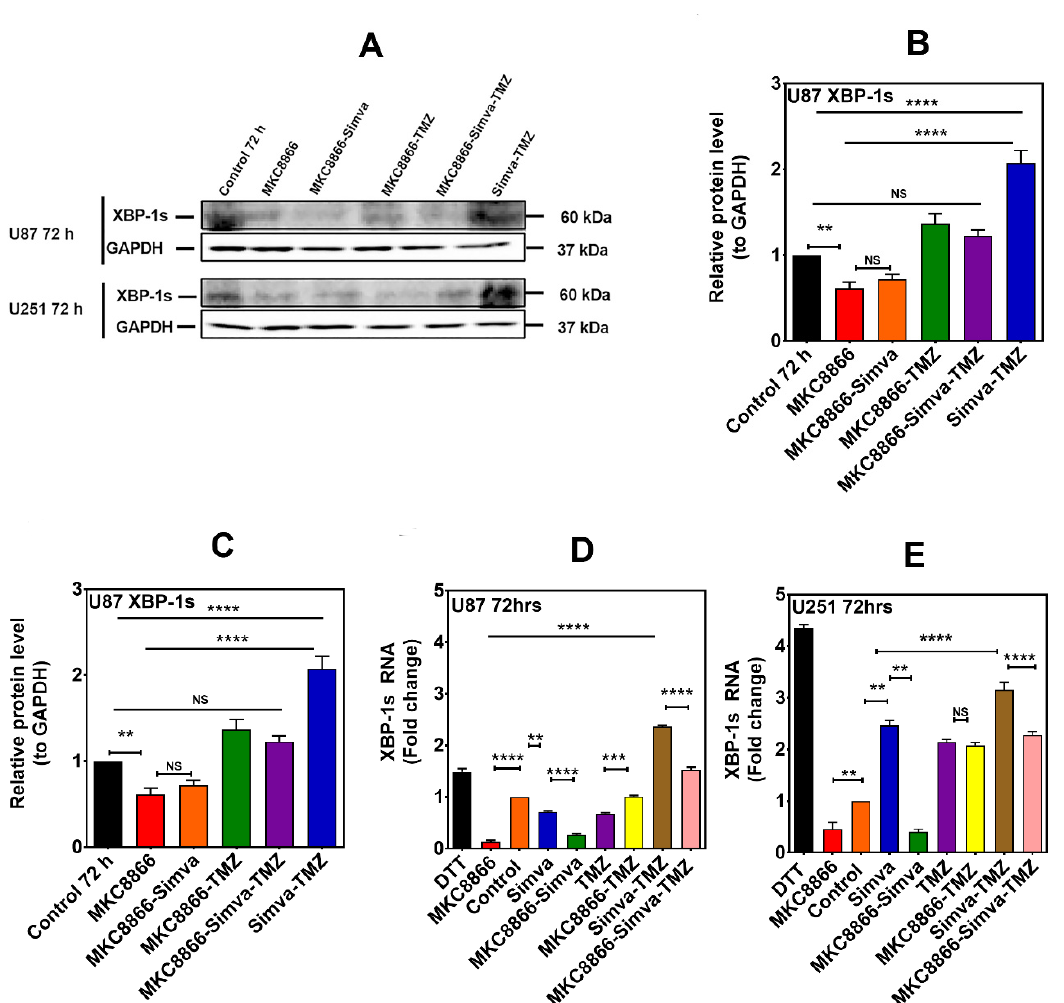
Figure 3. Simva–TMZ treatment induces IRE1 activation in GBM cells. ( A ) U87 and U251 cells were pretreated with MKC8866 (30 µM, 4 h), followed by co-treatment with TMZ, Simva, or Simva–TMZ for 72 h. XBP-1s protein levels were determined by Western blot analysis; GAPDH was used as the loading control. Simva–TMZ induced XBP-1 splicing in GBM cells, which was inhibited by MKC8866. ( B , C ) Densitometric analysis of the Western blot bands confirmed that Simva–TMZ significantly ( p < 0.0001) induced XBP-splicing in an IRE1 α -dependent manner. ( D , E ). U87 and U251 cells were pretreated with MKC8866 (30 µM, 4 h) and then co-treated with TMZ, Simva, or Simva–TMZ for 72 h, after which and XBP-1s mRNA expression was measured by real-time PCR. In line with the effects on protein amount, Simva–TMZ significantly ( p < 0.0001) induced XBP splicing, which was inhibited by MKC8866. The data are expressed as the mean ± SD of three independent experiments ** p < 0.01, *** p < 0.001; **** p < 0.0001).